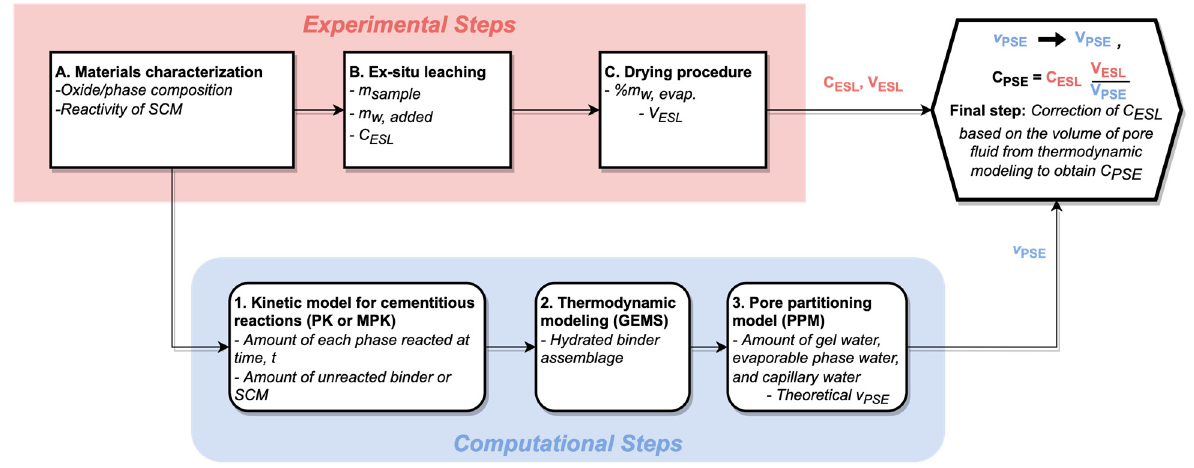
Figure 1. Flowchart of proposed approach for determining the pore solution concentrations of Na + and K + from ex ‐ situ leaching and thermodynamic